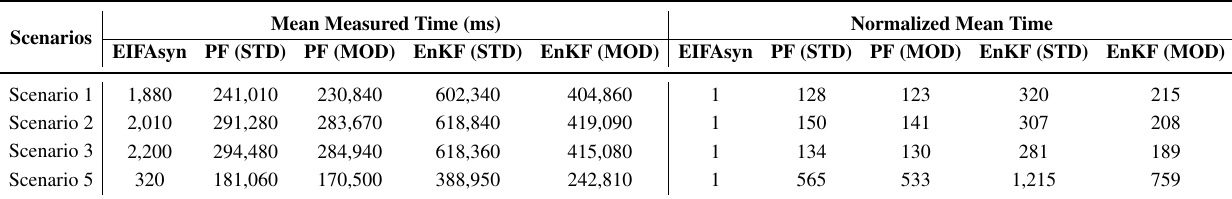
Table 3. Computational Cost